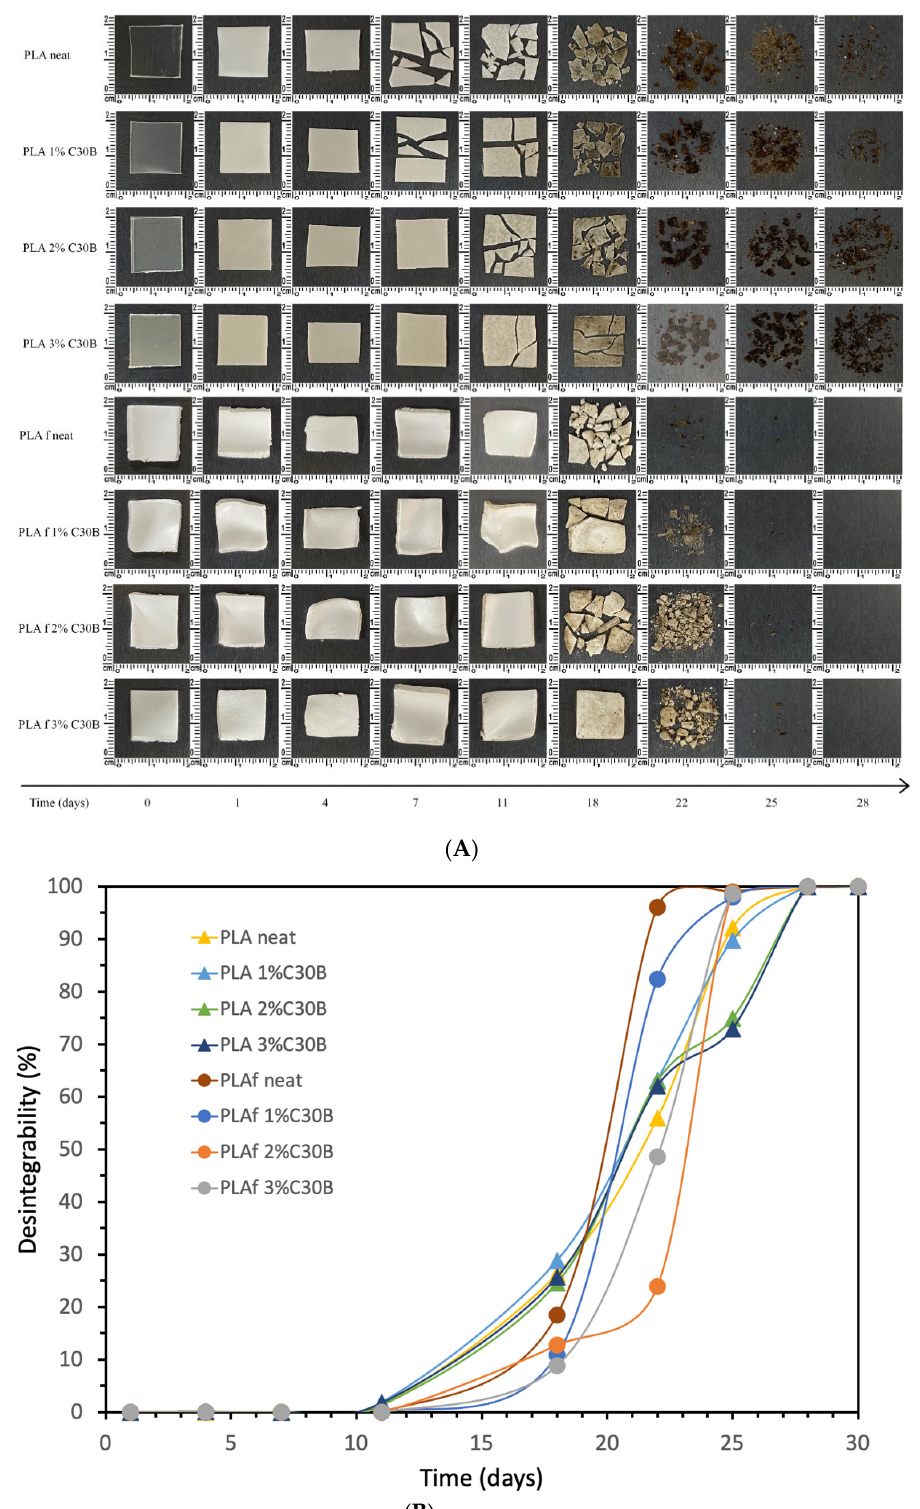
Figure 14. Disintegration under standard composting conditions of bionanocomposite film and foam samples. ( A ) visual appearance before and after different incubation days under composting conditions; ( B ) films’ and foams’ disintegration degree under composting conditions as a function of time.